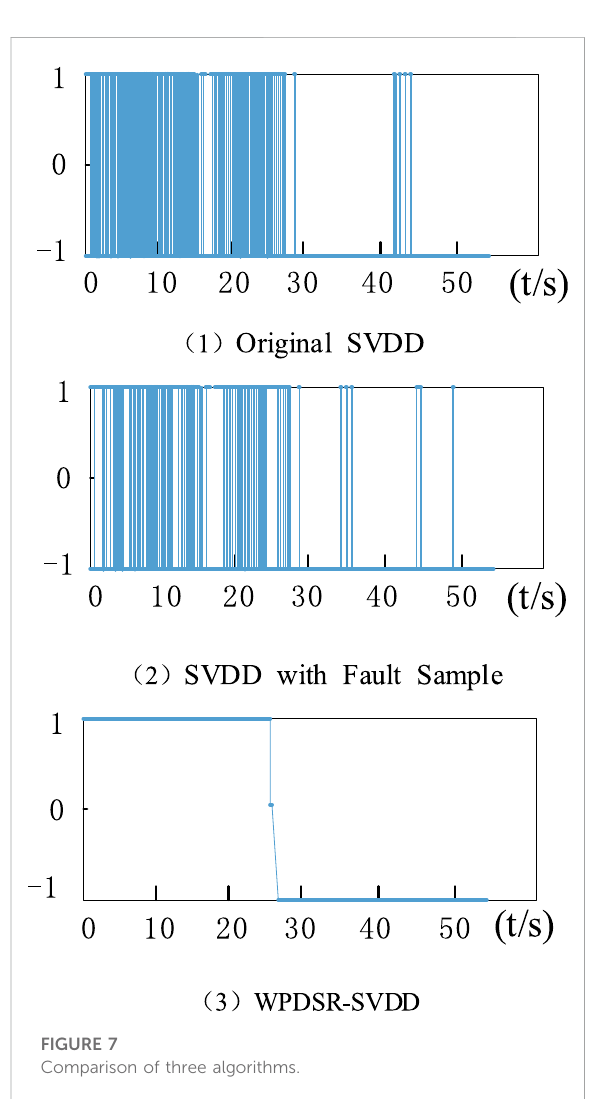
FIGURE 7 Comparison of three